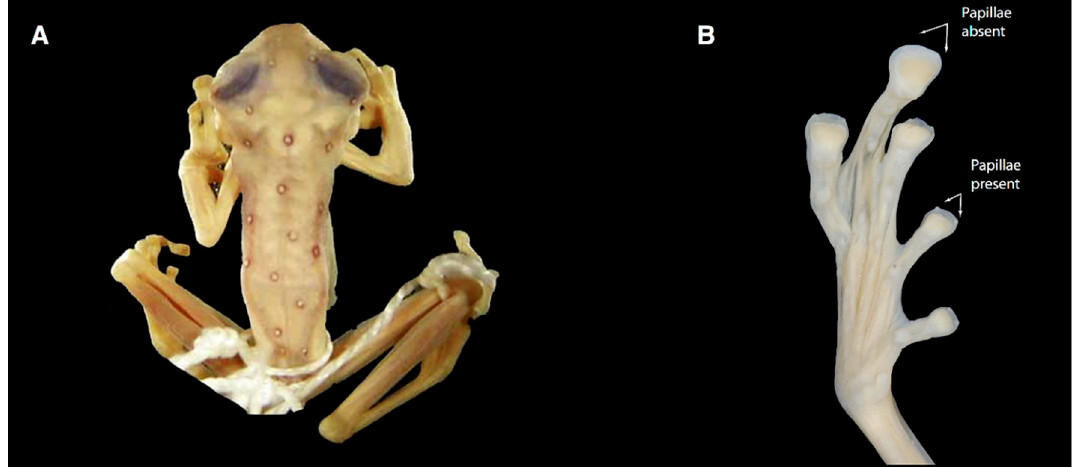
Figure 163. Nymphargus laurae in preservative, USNM 288453, from Ecuador, lower slopes of Volcán Sumaco. ( A ) Dorsal view of holotype. ( B ) Ventral view of foot; note presence of two papillae on each toe disc, except Toe IV. Photos by James Poindexter.